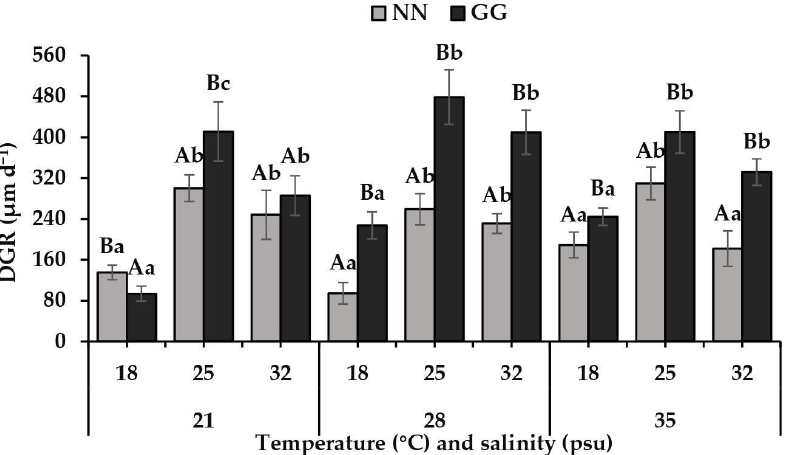
Figure 2. Comparison of the daily growth rate (DGR) of C. nippona and C. gigas spat exposed to different combinations of temperatures (18, 25 and 32 °C) and salinities (21, 28 and 35 psu) for 30 days. Different lowercase letters indicate significant differences at different temperatures for the same salinity level within the same species, while different uppercase letters represent significant differences between the NN and GG groups at the same environmental condition ( p < 0.05). Table 2. Analysis of variance (three-way ANOVA) testing the factor effects (temperature, salinity and species) on the daily growth and survival rates of spat.